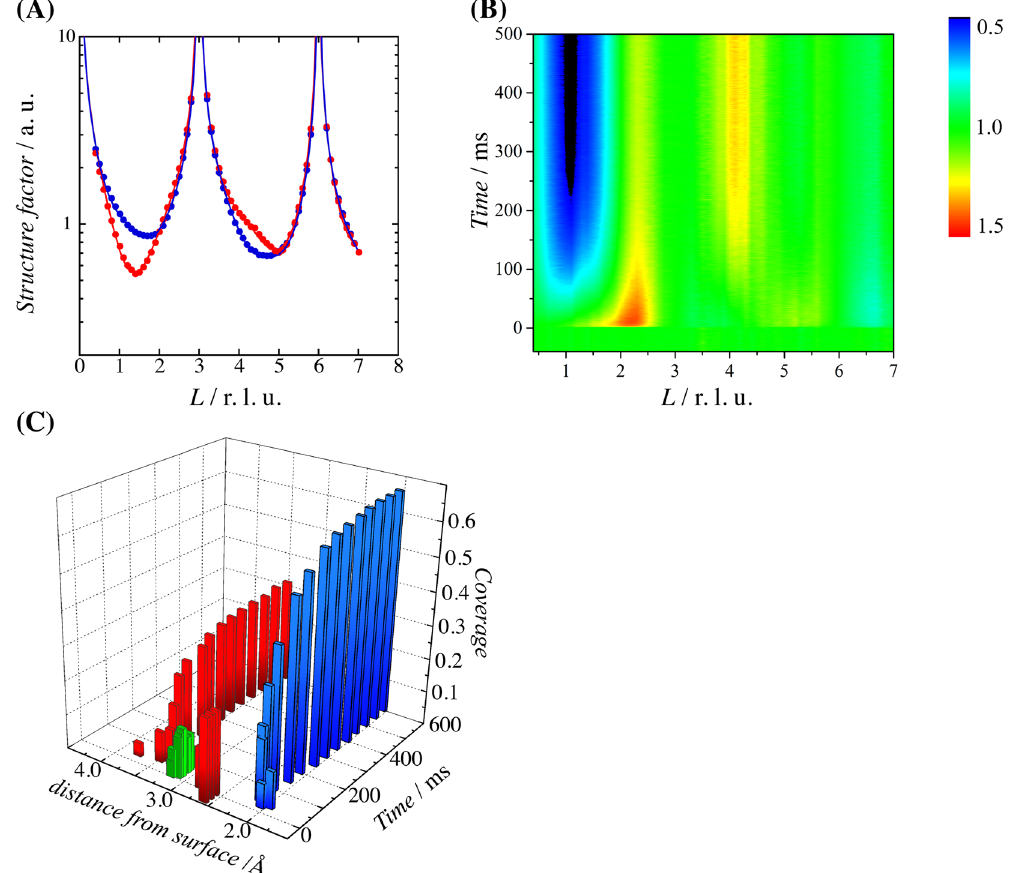
1.05 V. Red and blue regions indicate the increase and decrease of intensity, respectively. ( C ) Time dependence of the structural parameters optimized using time–resolved specular CTR. The blue, red, and green